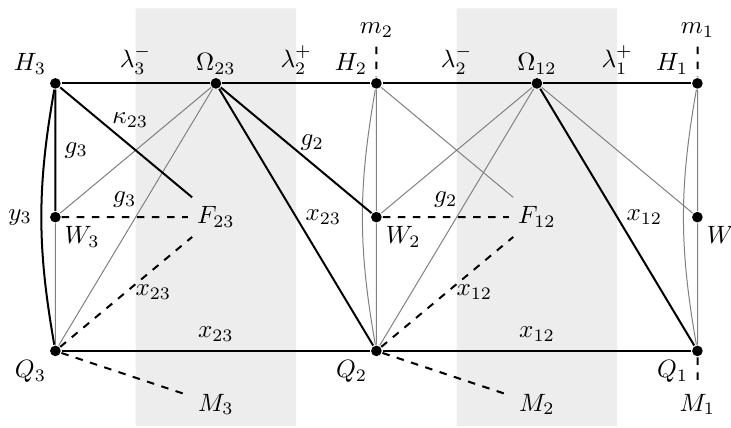
Figure 1 . Diagram showing how to connect H 3 (top left) to the various mass parameters of the theory at a given order in the expansion in terms of loops (in one-to-one correspondence with the lines) and couplings (indicated over each line), within the full model (see main text). The faint gray lines correspond to loops/couplings which are less dangerous for the stability of the